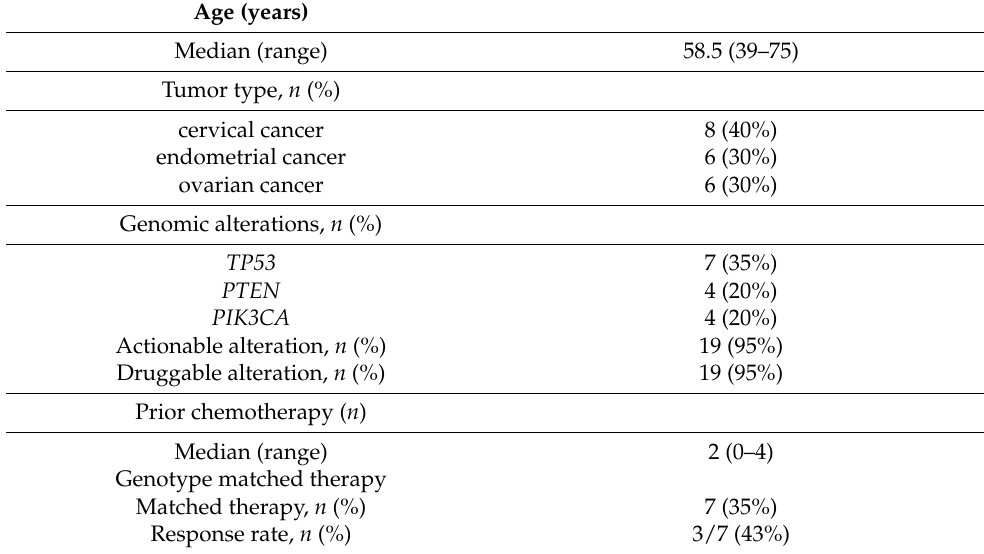
Table 1. Patient characteristics ( n =